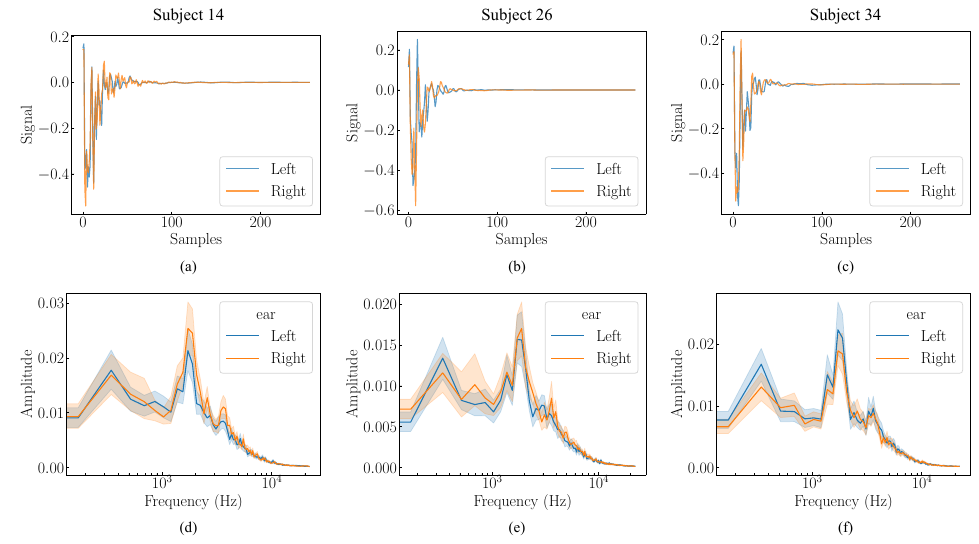
Figure 4. Preprocessed ECIR data and their frequency characteristics of three subjects. ( a , d ) Subject No. 14. ( b , e ) Subject No. 26. ( c , f ) Subject No. 34.